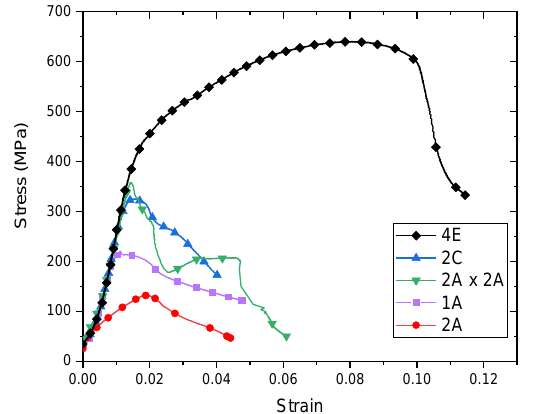
Figure 3. Experimental compression stress-strain curves for Cu-Ta composites consolidated at ambient temperature.